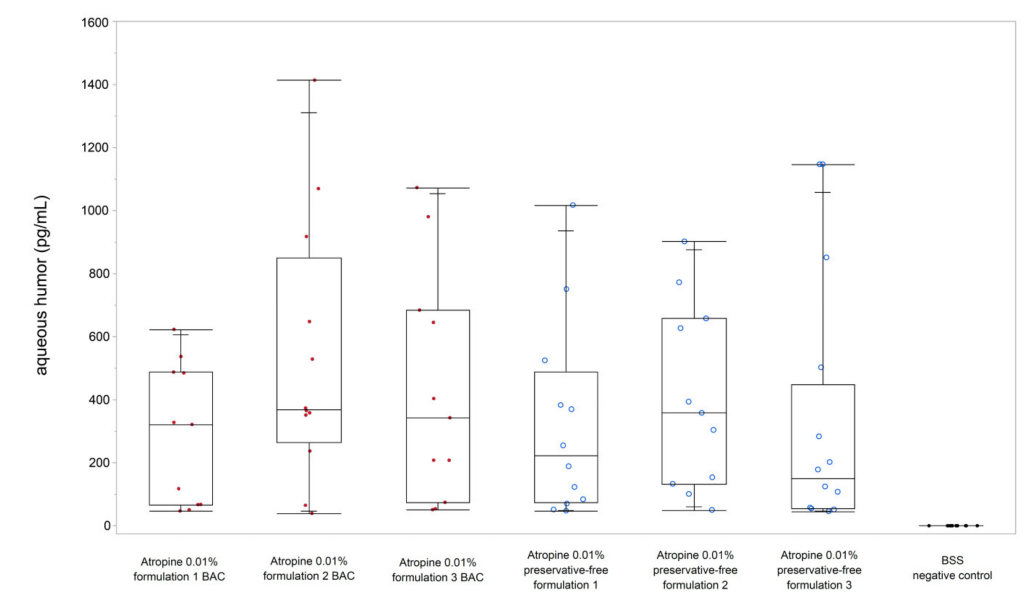
Figure 1. Concentration of atropine sulphate in aqueous humor for atropine 0.01% formulation with BAC (red) vs. preservative-free formulations. The bars within the box plots represent the median values, the edges represent the 25th/75th percentiles, and the whiskers extend from the ends of the boxes to the outermost data points within the quartile—1.5 × of the interquartile range.